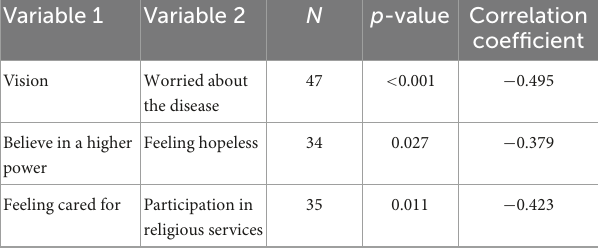
TABLE 11 The results of the Kruskal–Wallis test for Romania, Germany, and the USA.